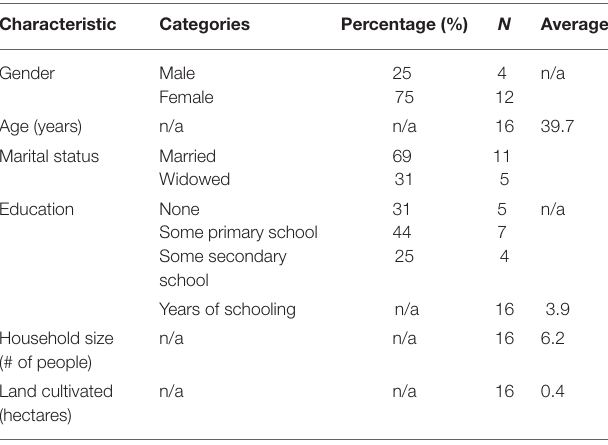
TABLE 2 | Results from quinoa taste trial at Total Landcare in Lilongwe ( N = 12). Gender Would try again Would not try